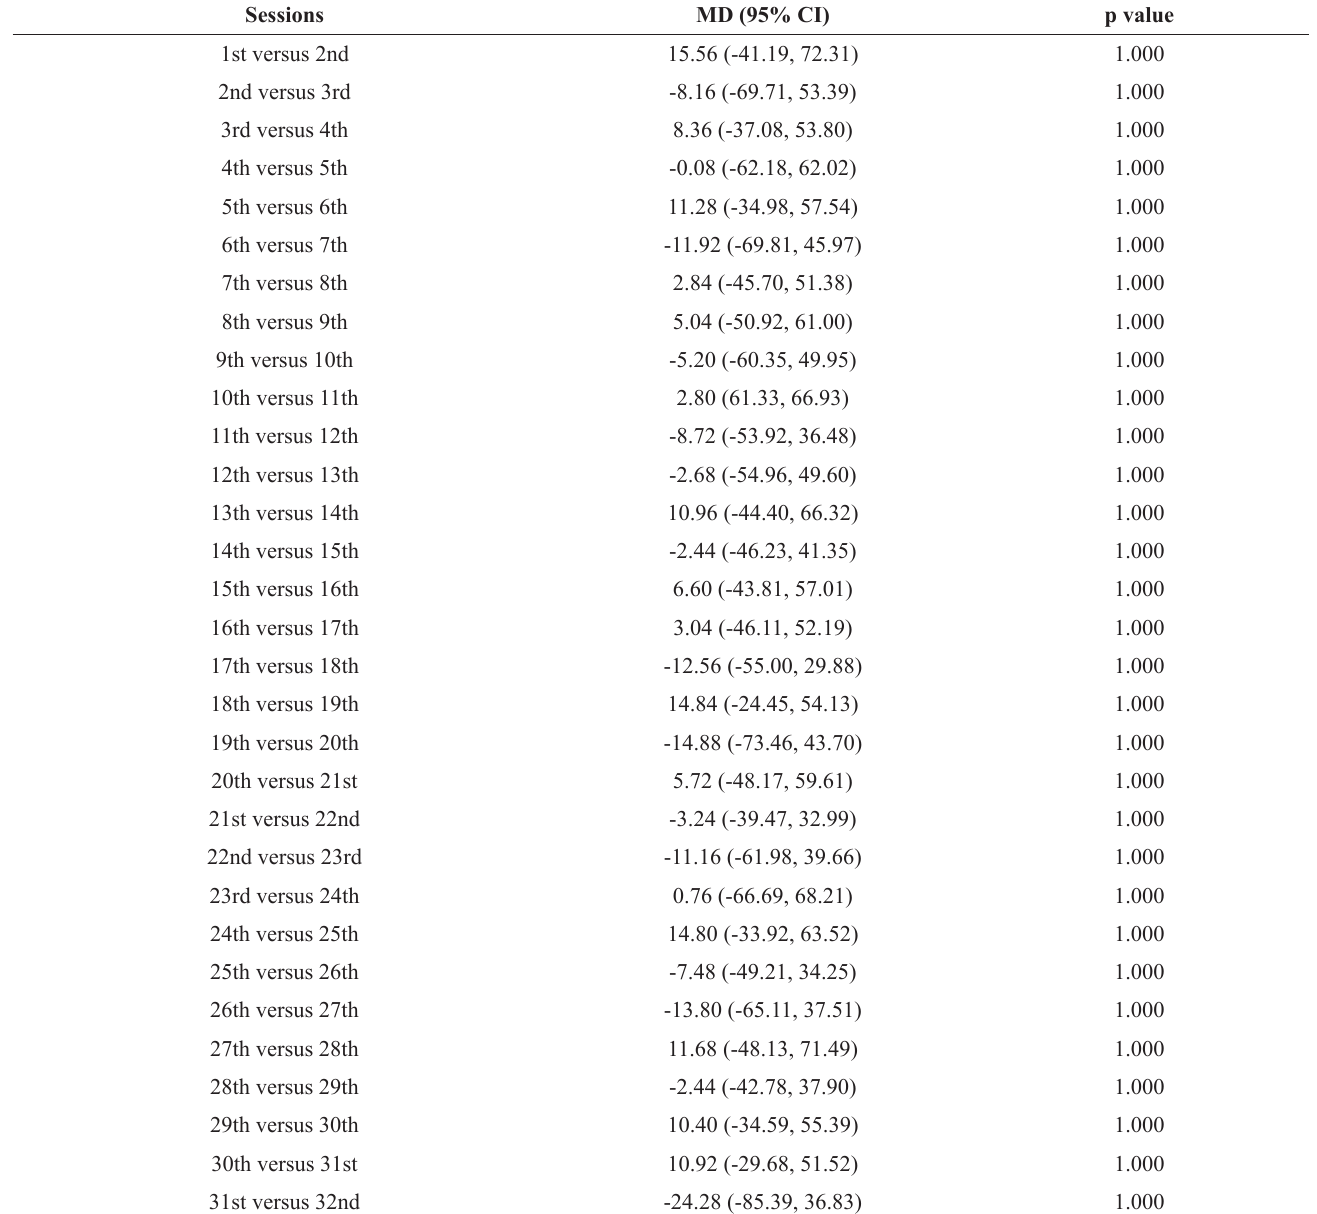
Table 3. Comparison of blood glucose values (mg/dL) before each session of strength and aerobic training